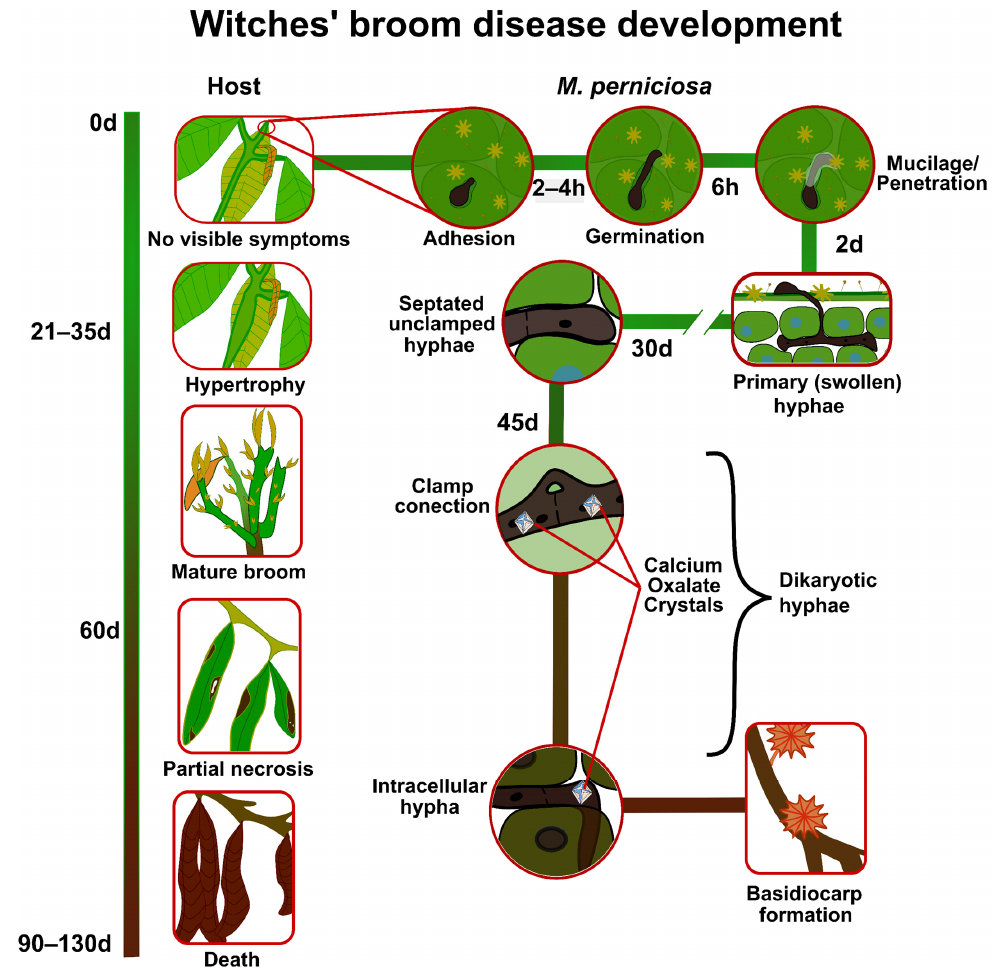
Figure 4. Developmental cycle of witches’ broom disease (WBD) over time in the most studied host ( Theobroma cacao ) of M. perniciosa involving the morphological and biochemical aspects of the compatible interaction; d = days; h = hours.